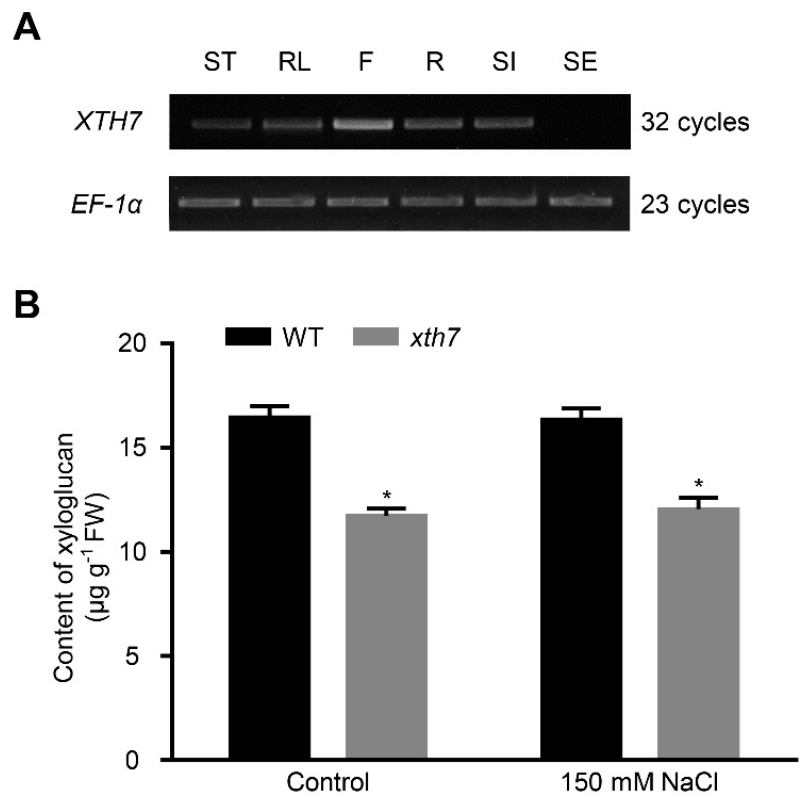
Figure 6. The xth7 mutant contains lower xyloglucan. ( A ) Expression levels of XTH7 in different tissues detected by RT-PCR. ST: stem; RL: rosette leaf; F: flower; R: root; SI: silique; SE: seed. ( B ) Extractable xyloglucan content of WT and xth7 plants with or without 150 mM NaCl treatment. The bars indicate means ± sd of three independent replicates. * p < 0.05 (Student’s t test).